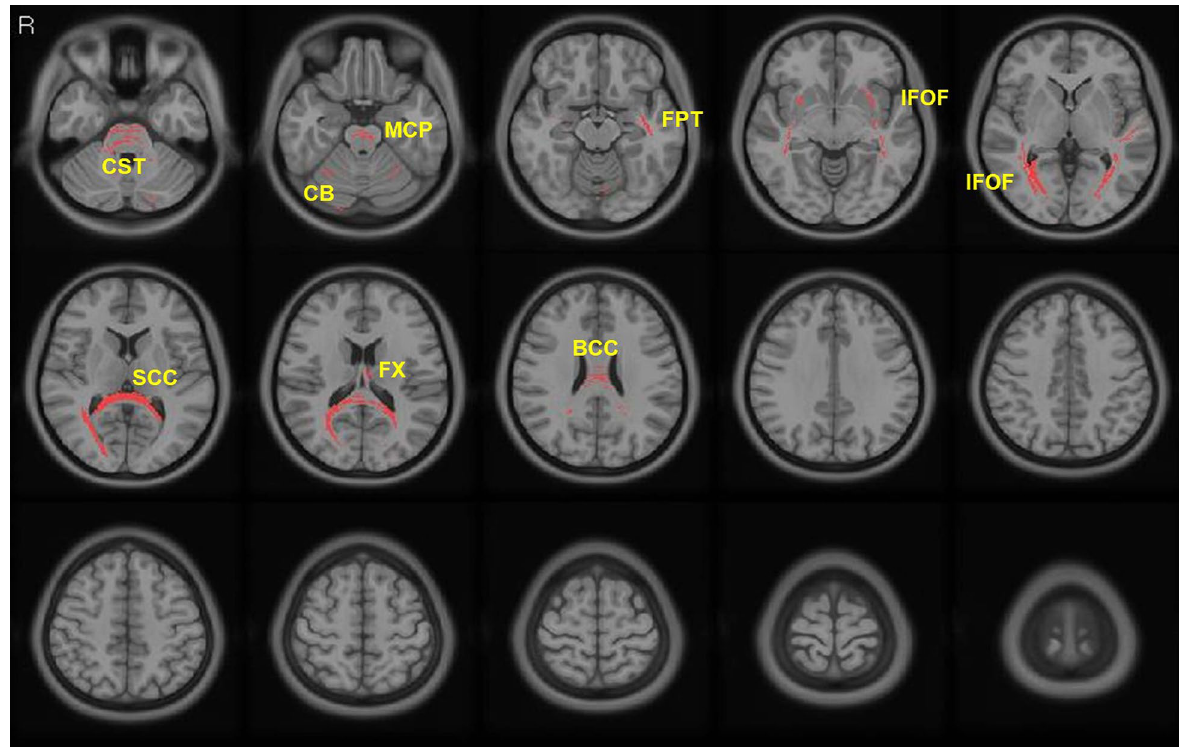
Fig. 3 Axial planes showing quantitative anisotropy (QA) signal enhancement in the brain using high‑dielectric pad. CST Corticospinal tract; MCP Middle cerebellar peduncle; CB Cerebellum; FPT Frontopontine tract; IFOF Inferior fronto‑occipital fasciculus; SCC Splenium of corpus callosum; FX Fornix; BCC Body of corpus callosum